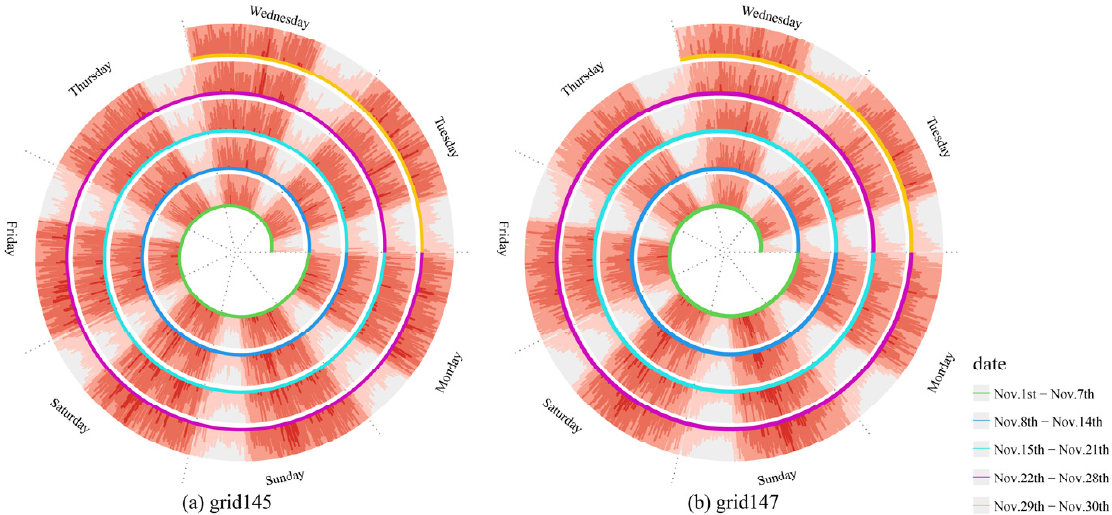
Figure 4. Spiral diagrams of the time series of online car-hailing traffic in grid145 ( a ) and grid147 ( b ). (Note: Different colors in the spiral graph indicate different weeks, and the spiral chart is divided into 7 parts, each representing the day of the week. The height of the bar indicates the size of the flow.)